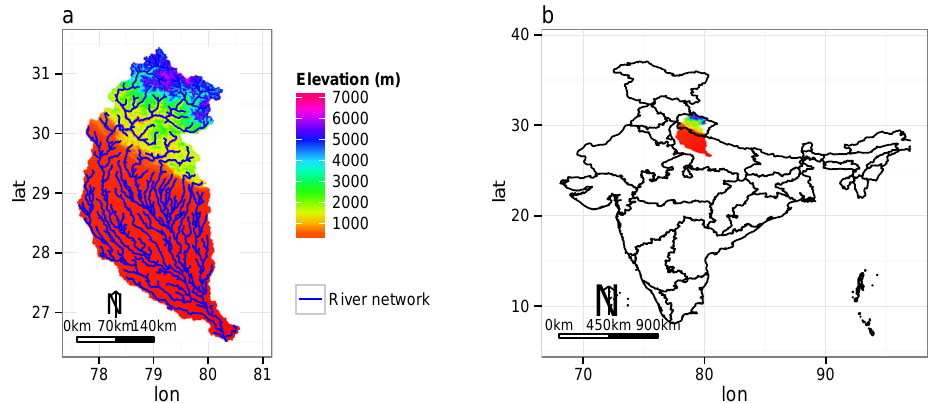
Figure 1. (a): Digital Elevation Model (DEM) of the UG Basin showing the ranges of the elevations (altitude in metres) and the river network. (b): location map of the study area in north India.